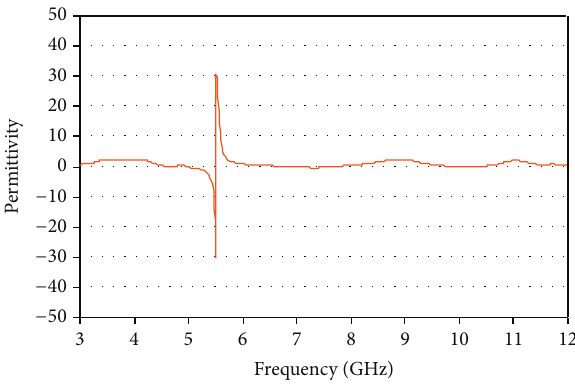
Figure 3: Extracted negative permittivity of CSRRs.